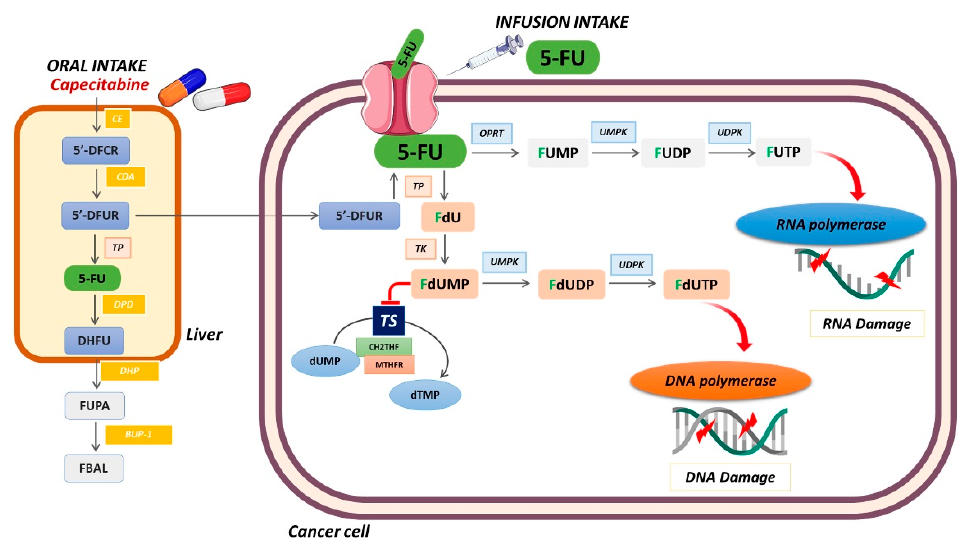
Figure 3. Schematic representation of fluoropyrimidine metabolism.